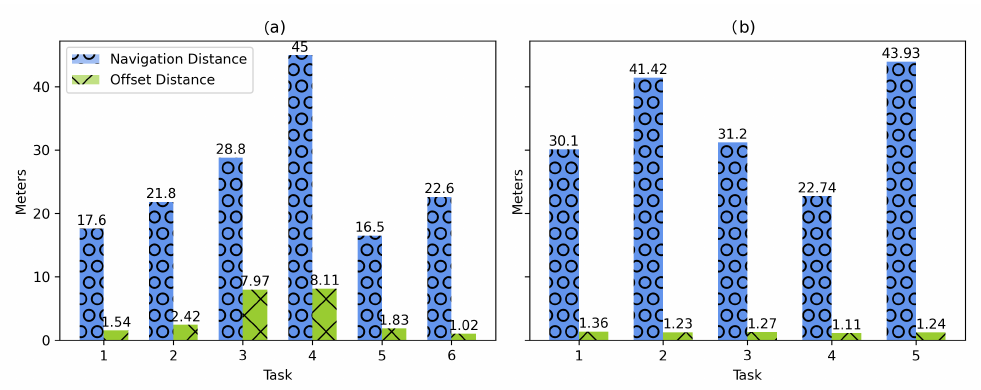
Figure 16. Navigation distance vs. offset distance by task. ( a ) University distances, ( b ) Cinvestav dis- tances.